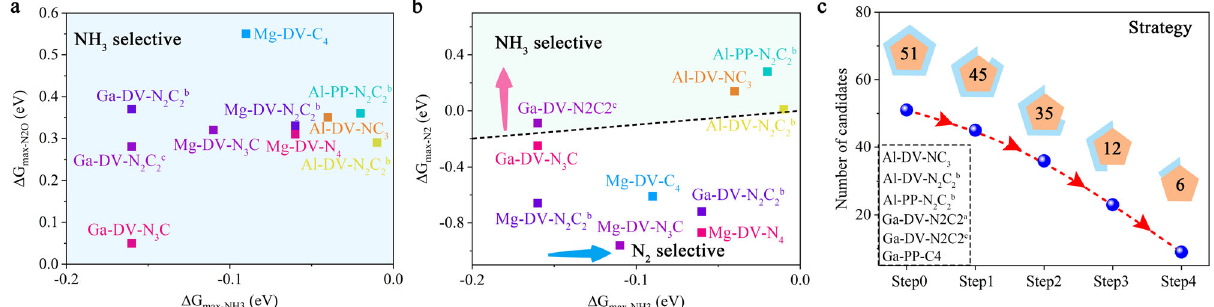
Fig. 4 Electrocatalytic selectivity and summary of the screening strategy for NORR toward NH 3 . a Δ G max-NH3 vs Δ G max-N2O . b Δ G max-NH3 vs Δ G max-N2 . c Illustration of the screening strategy applied to identify high-ef corresponding selected high-ef fi cient SAC